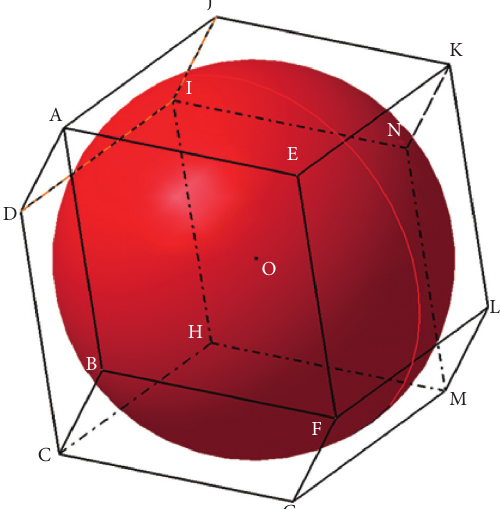
Figure 3: Illustration of a rhombic dodecahedron surrounding an inscribed ball with radius